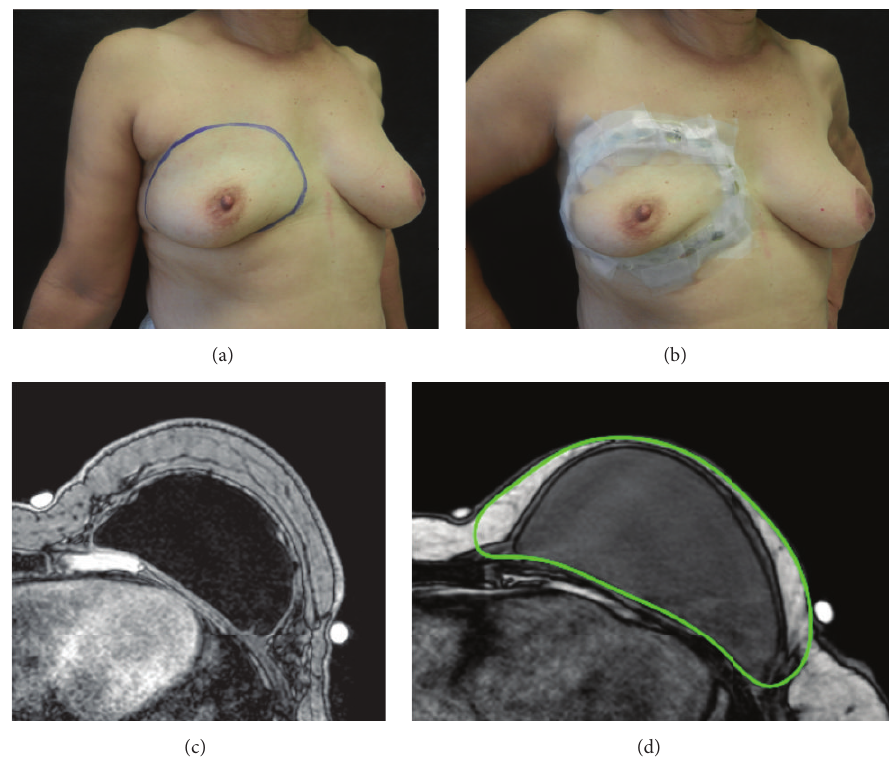
Figure 1: Method for MRI-based breast volume measurement. (a) Breast boundaries demarcated, (b) external markers applied, (c) axial sequence showing the breast medial and lateral limits, and (d) a selected region of interest (ROI) with the OsiriX